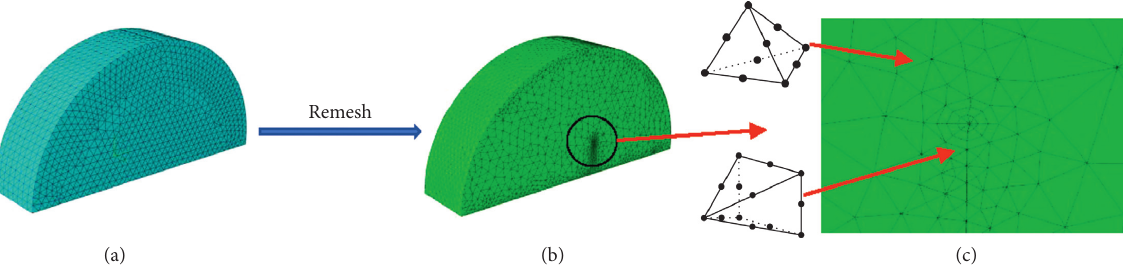
Figure 2: Grid model of SCB specimen. (a) Abaqus mesh. (b) Franc3D mesh. (c) Crack tip mesh.